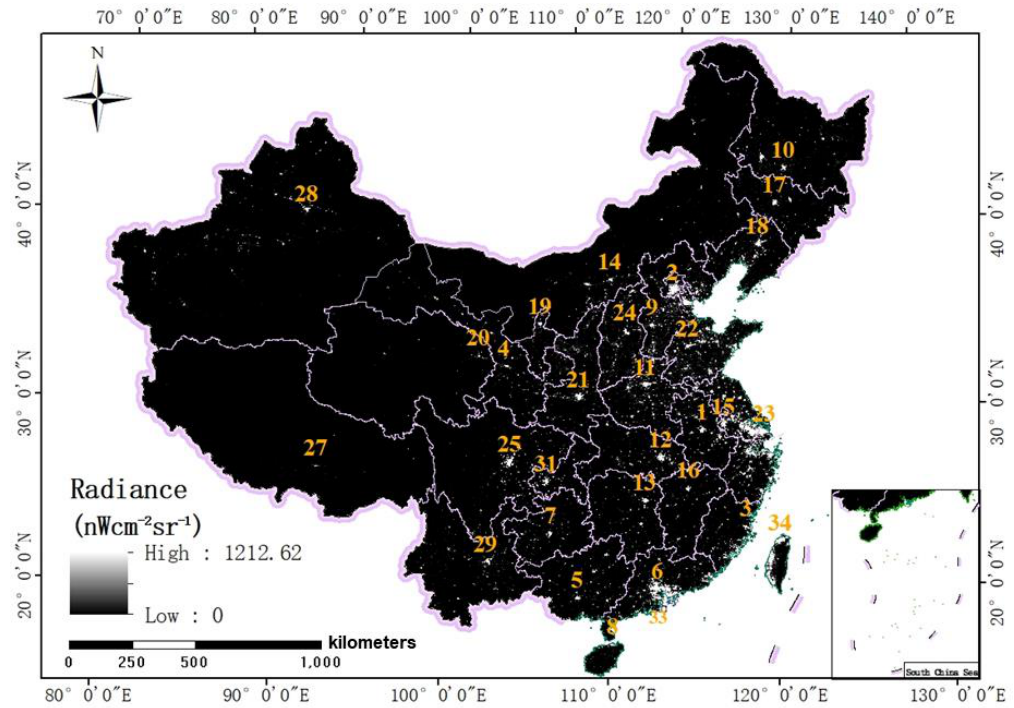
Figure 2. The 2015 VIIRS Cloud Mask-nighttime light (VNL) in China (1. Anhui, 2. Beijing, 3. Fujian, 4. Gansu, 5. Guangxi, 6. Guangzhou, 7. Guizhou, 8. Hainan, 9. Hebei, 10. Heilongjiang, 11. Henan, 12. Hubei, 13. Hunan, 14. Inner Mongolia, 15. Jiangsu, 16. Jiangxi, 17. Jilin, 18. Liaoning, 19. Ningxia, 20. Qinghai, 21. Shaanxi, 22. Shandong, 23. Shanghai, 24. Shanxi, 25. Sichuan, 26. Tianjin, 27. Tibet, 28. Xinjiang, 29. Yunnan, 30. Zhejiang, 31. Chongqing, 32. Hongkong, 33. Macao, 34. Taiwan).